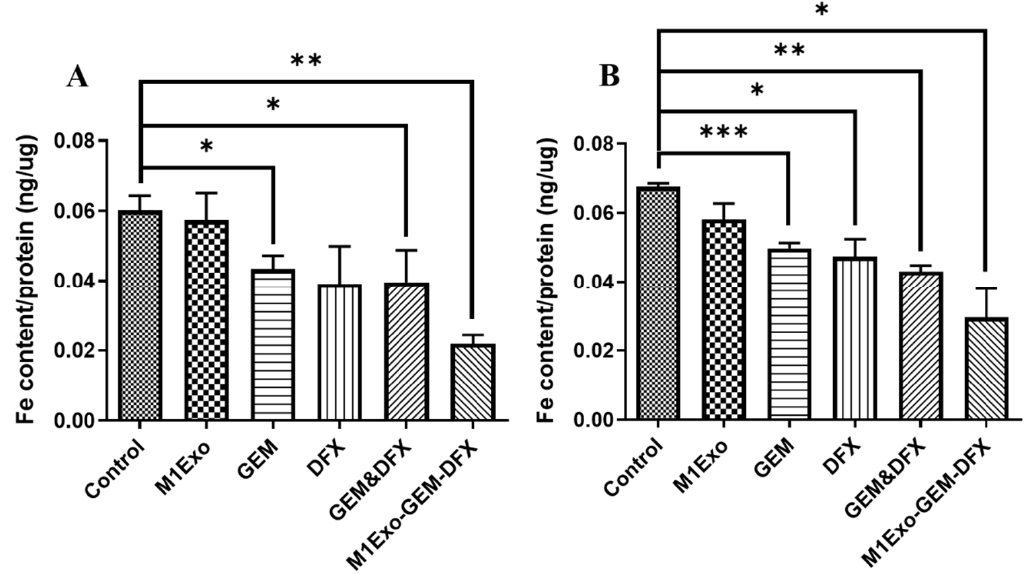
Figure 3. Iron removal efficacy of M1Exo, GEM, DFX, GEM&DFX, and M1Exo-GEM-DFX at a corresponding concentration of GEM and DFX in ( A ) PANC-1 cells and ( B ) PANC-1/GEM cells. (* p < 0.05, ** p < 0.01, *** p < 0.001).